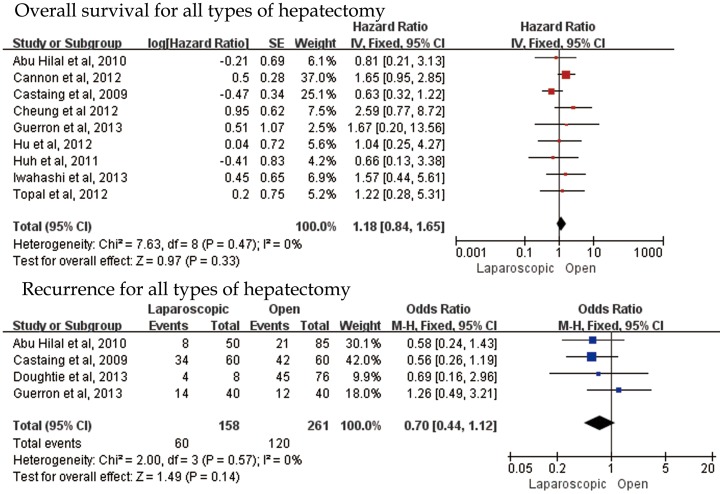
Forest plot of long-term results on overall survival and recurrence in all types of hepatectomy.